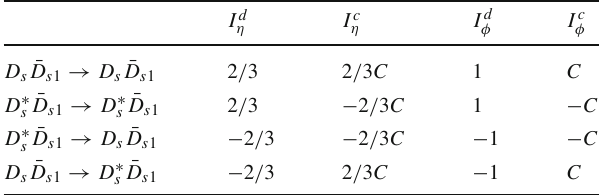
Table1 Theflavorfactorsforcertainmesonexchangesofcertaininter- action. The C is the charge